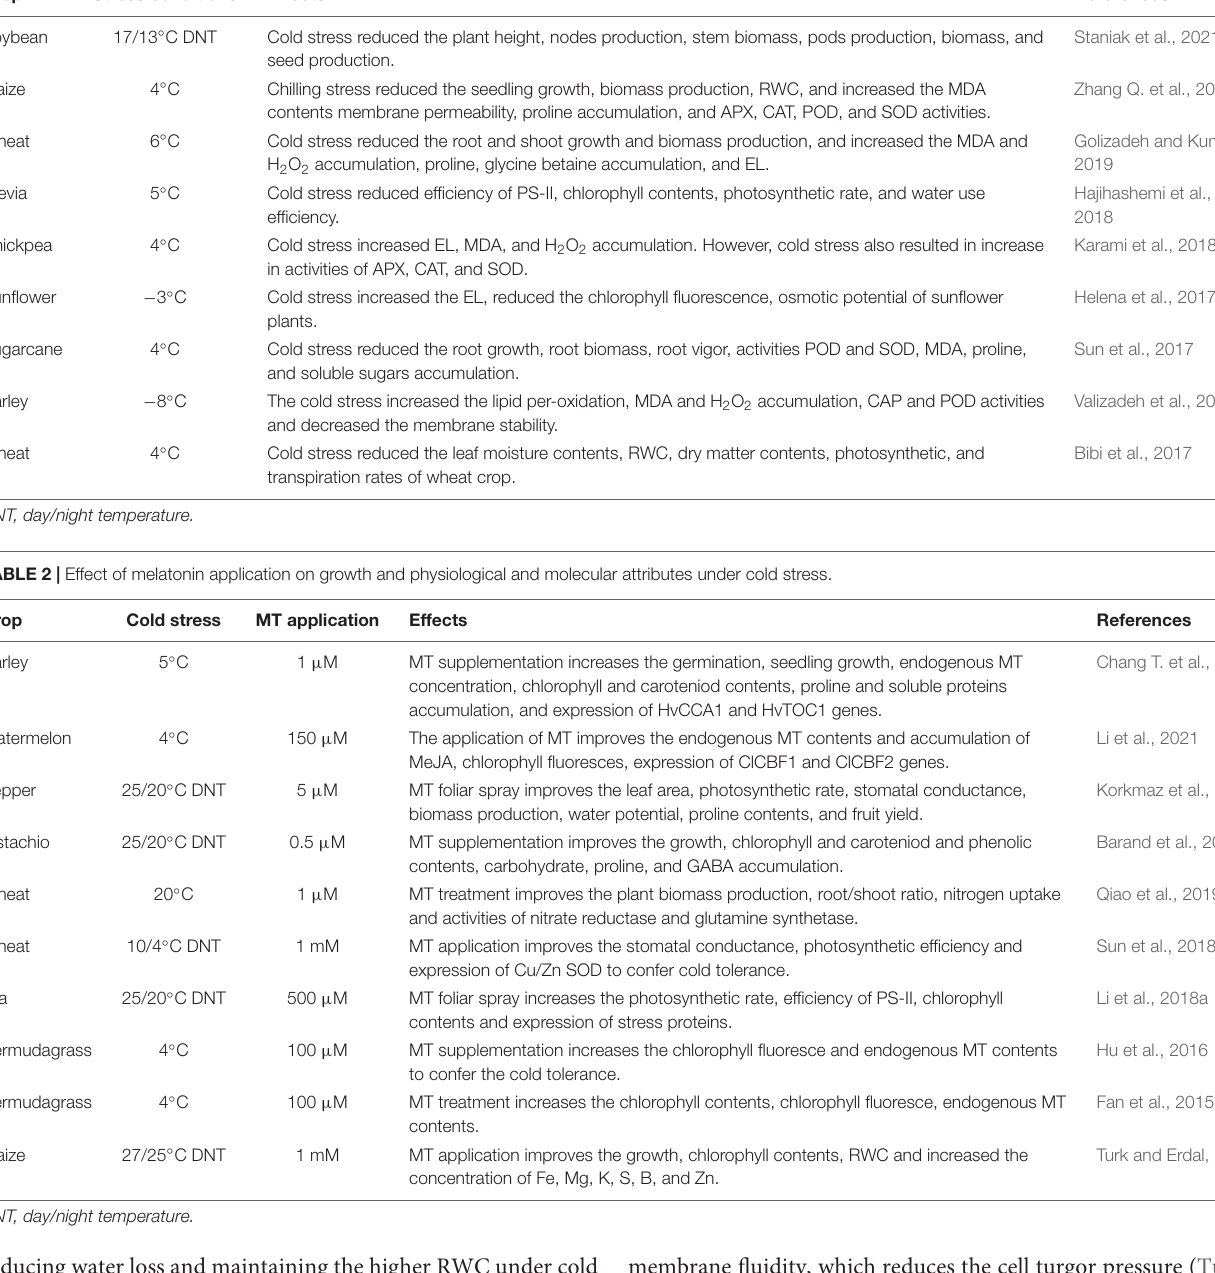
TABLE 1 | Effect of cold stress on growth, physiological attributes, and anti-oxidant activities. Crop Stress conditions